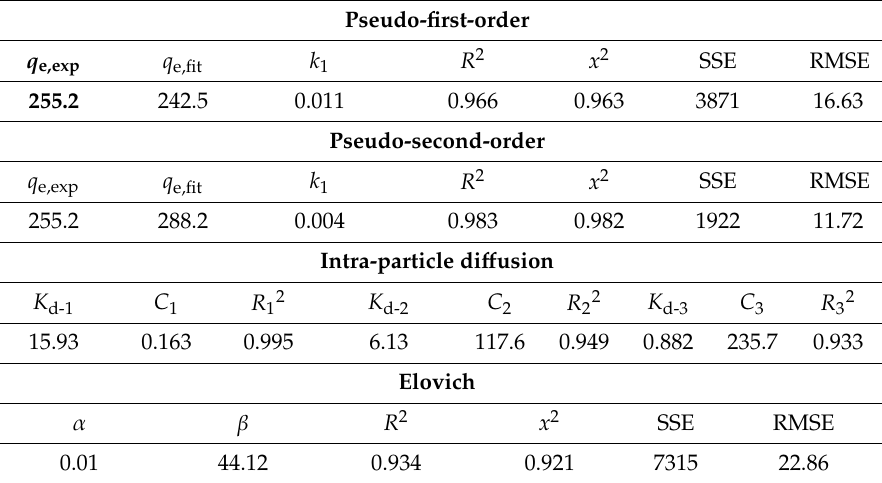
Table 2. Kinetic fitting for adsorption of Hg 2+ onto PPy-Fe 3 O 4 /Kaolin. Pseudo-first-order